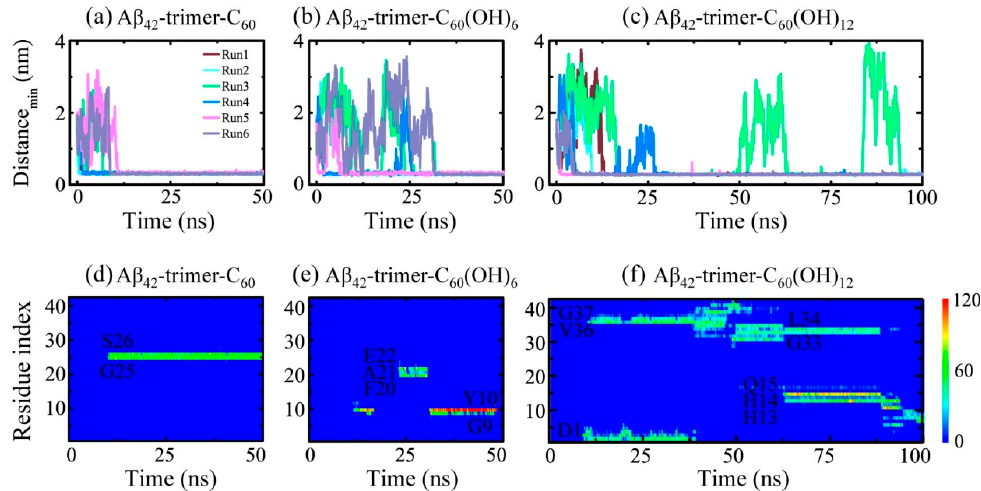
Figure 2. Dynamics of the fullerene/fullerenol molecule binding to A β 42 -trimer. ( a – c ) Time evolution of the minimum distance between A β 42 -trimer and fullerene/fullerenol. Six independent molecular dynamics (MD) runs are denoted in different colors. ( d – f ) Time evolution of the number of contacts between individual residue of A β 42 -trimer and fullerene/fullerenol in a representative MD run for each simulated system.